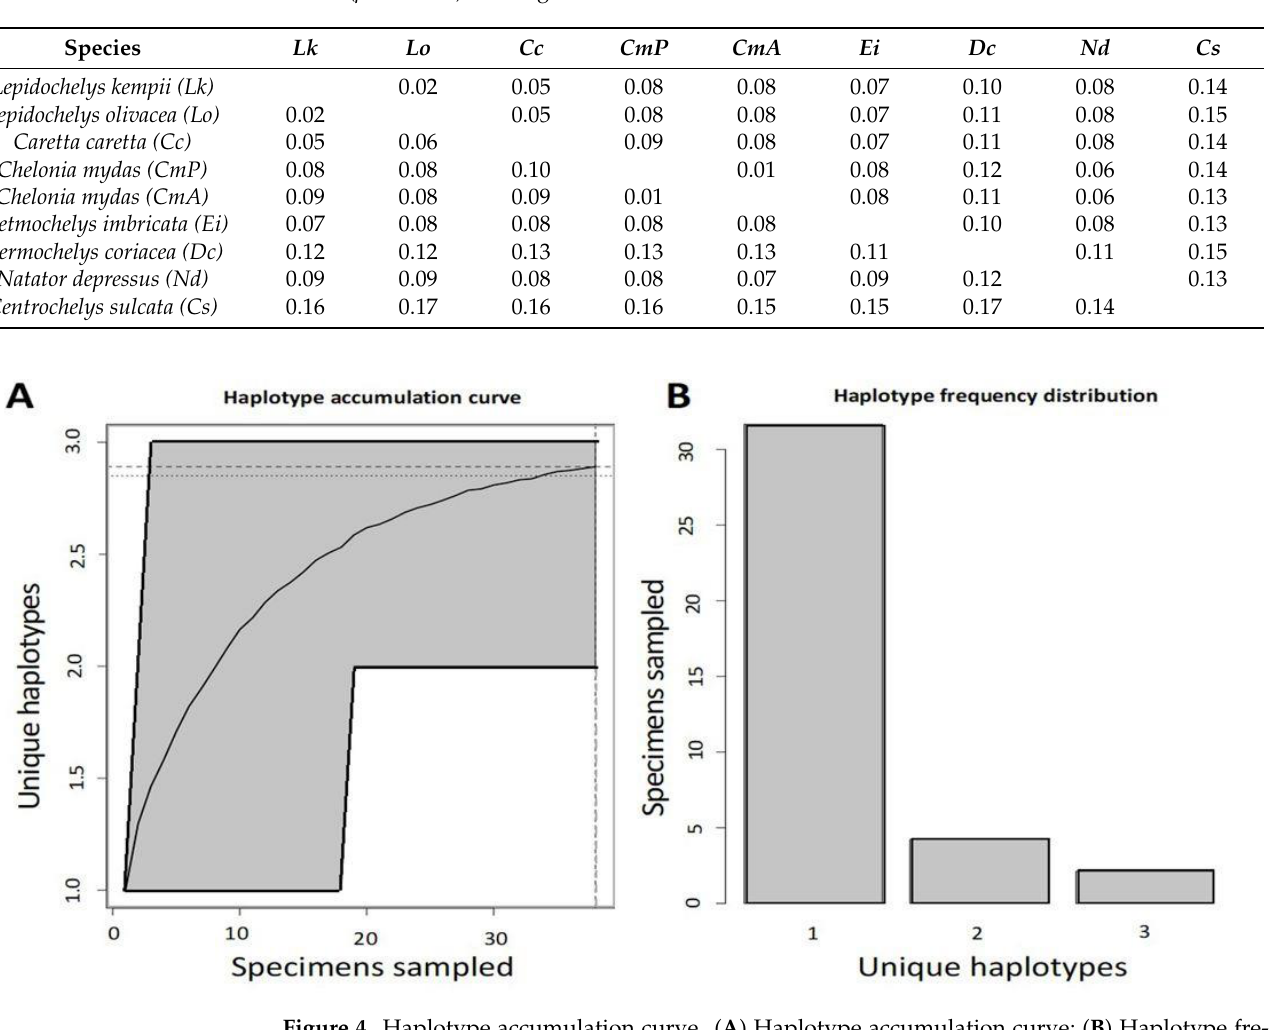
Table 3. Interspecific distance established between COI gene sequences among Kemp’s ridley ( Lepidochelys kempii ) collected in Mexico and sequences described in BOLDSystem from other sea turtle species, 2010, 2018–2019. Mean pairwise divergences between species are below (K2P) and above ( p -distance) the diagonal.